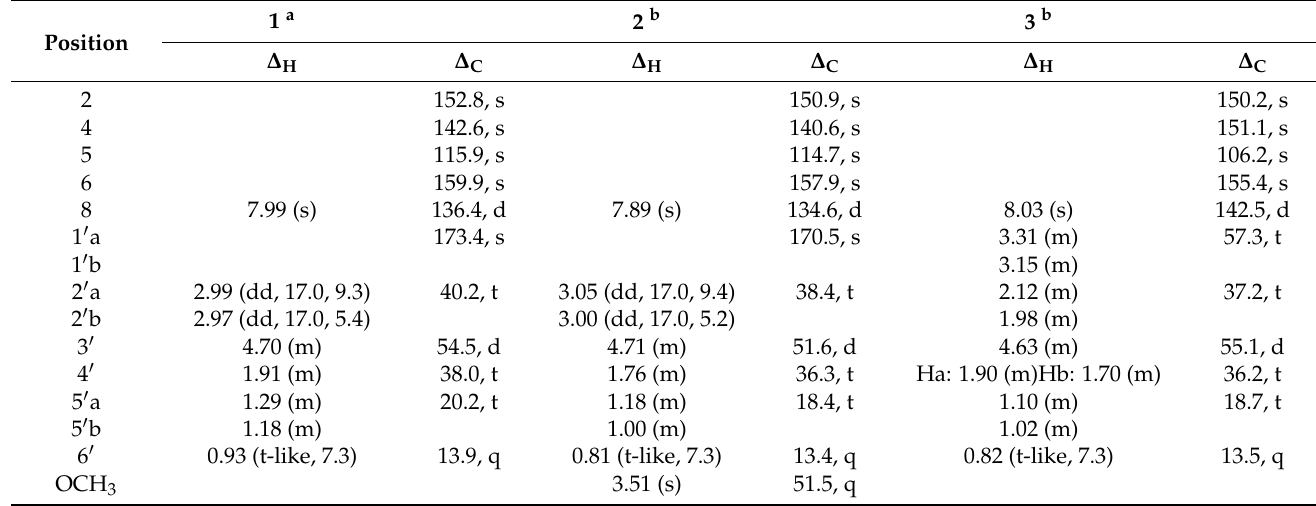
Table 1. 1 H- (600 MHz) and 13 C-NMR (150 MHz) data of 1 – 3 ( Δ in ppm, J in Hz).